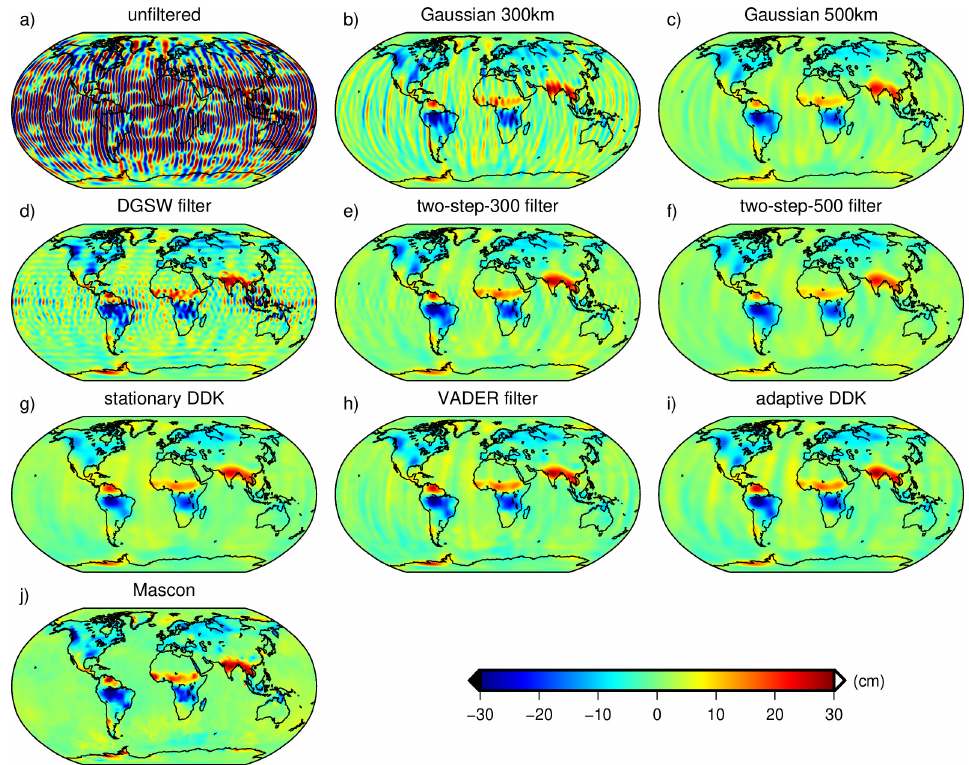
Figure 5. The unfiltered and filtered solutions expressed in EWH in September 2006. Note that the ECMs in all DDK filters are the same and the hyperparameters in them are optimized according to the GCV criterion.